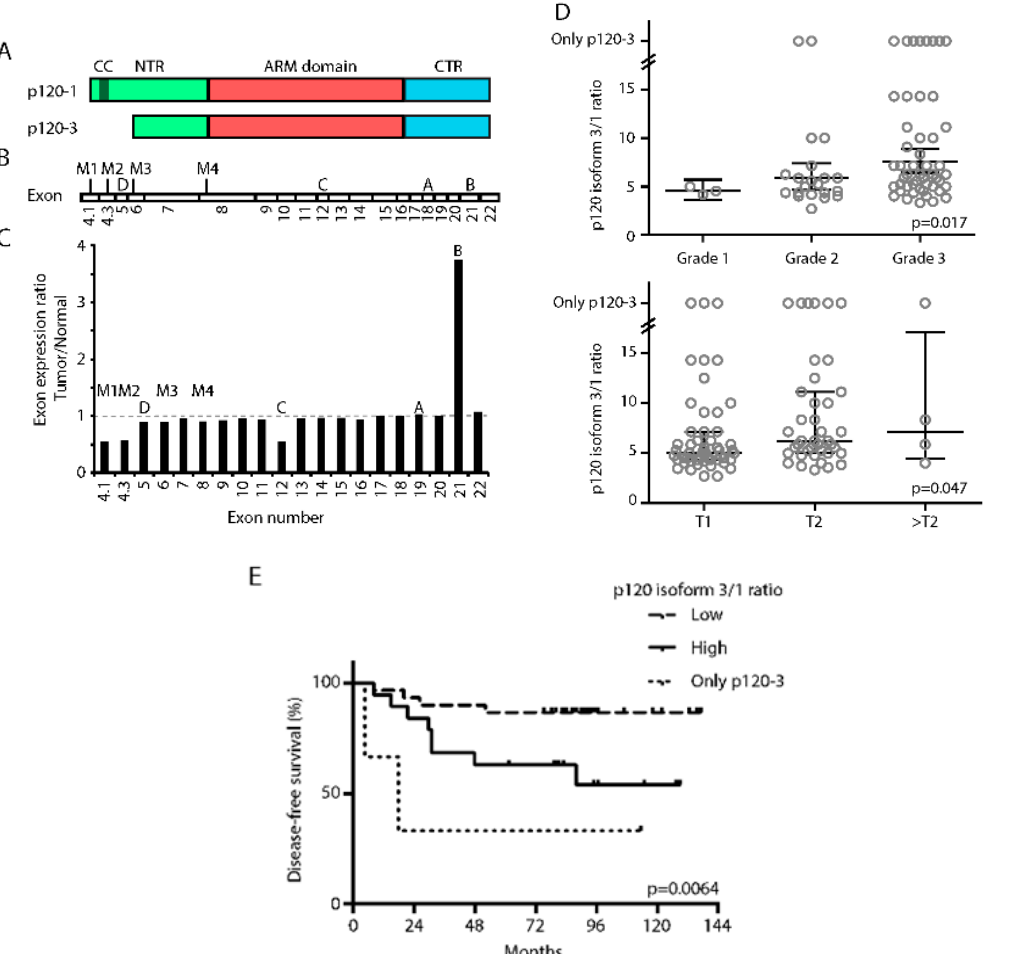
Figure 1. P120 isoform expression is changed in invasive breast cancer and correlates with poor prognosis. ( A ) Schematic overview of P120-1 and P120-3 protein structure. CC, coiled coil domain; NTR, N-terminal region; ARM, Armadillo repeat domain; CTR, C-terminal region. ( B ) Schematic overview of the exons in the CTNND1 gene coding for P120 protein. The alternative entry points are indicated by M1, M2, M3 and M4, and the corresponding encoding alternative exons are indicated with the numbers below. The alternative exons A, B, C and D are indicated with their respective letters. ( C ) CTNND1 exon expression ratios of tumor/normal mRNA from the TCGA-BRCA database. Alternative entry points and exons are indicated above the bars. ( D ) Correlation between P120-3/P120-1 isoform encoding ratios in human breast cancer tissues and pathological features. Significant positive correlations were found between P120-3/P120-1 isoform ratio and tumor grade (Spearman correlation, Rs = 0.217, p = 0.017) and size (Kruskal–Wallis, p = 0.047). ( E ) Significant differences in survival depending on P120-3/-120-1 isoform ratio of patients with T1 breast tumors (Mantel–Cox test, p = 0.0064).